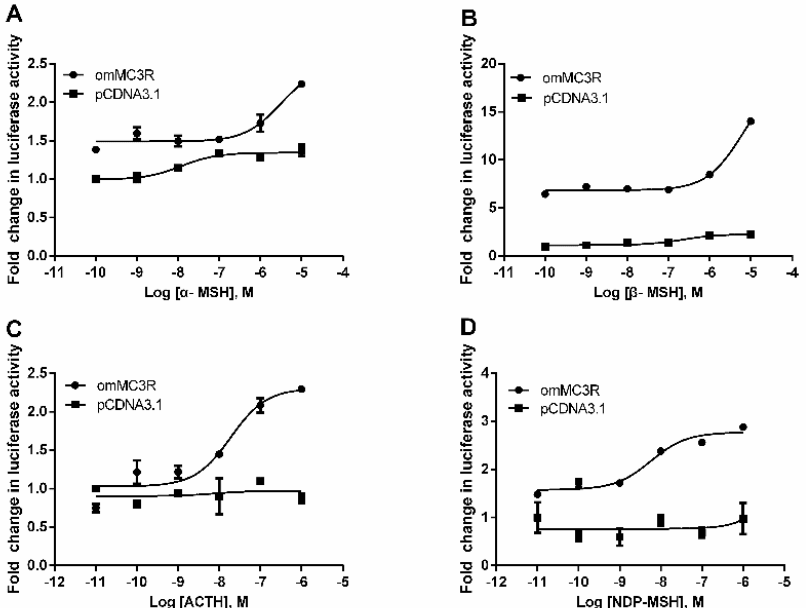
Figure 6. Activation of MAPK/ERK signaling mediated by omMc3r. The pGL4-SRE luciferase reporter system (pGL4.33 vector) was used to monitor the ERK1/2 signaling. HEK293T cells were co-transfected with pGL4.33 and omMc3r vectors were treated with α -MSH ( A ), β -MSH ( B ), ACTH (1–24) ( C ), and NDP-MSH ( D ) for 6 h, and then lysed for measurement of luciferase activity. The results were shown as fold change of the agonist-treated groups relative to the DMEM serum-free medium-treated group, and the empty vector pcDNA 3.1 was used as a negative control. Each data point represents mean (SD) of three independent